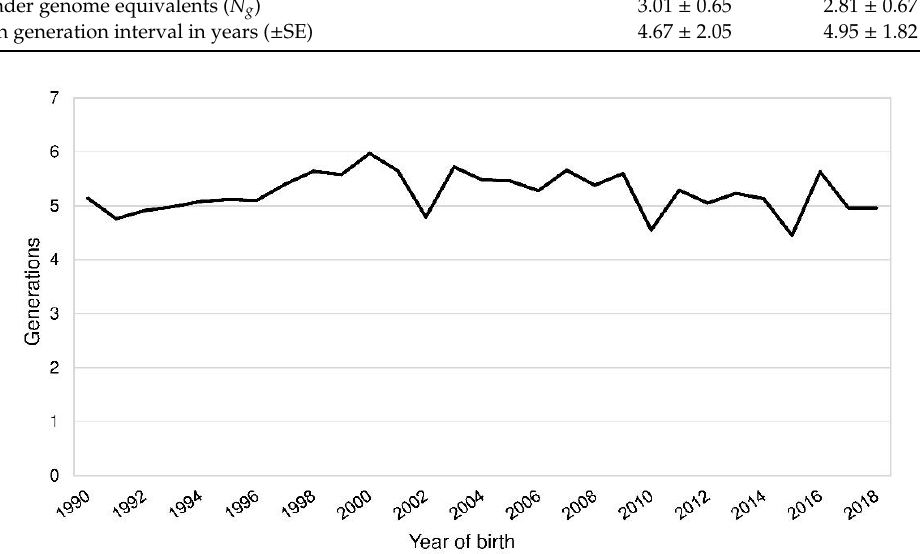
Figure 2. Mean complete generations by the year of birth of Polish Lowland Sheepdogs